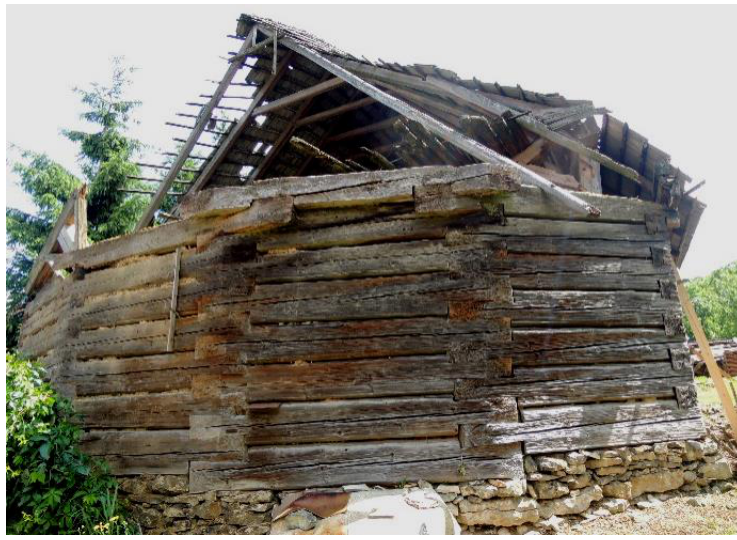
Figure 1. Polygonal timbered barn before dismantling .